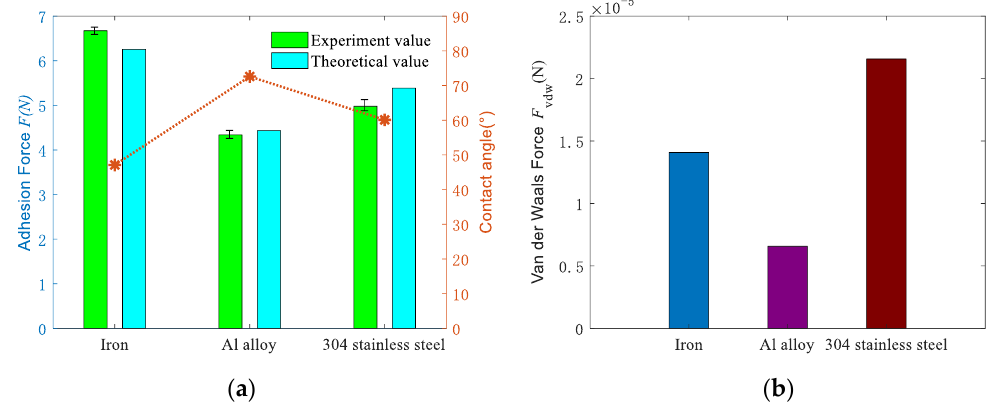
Figure 6. Influence of different materials on adhesion and van der Waals force: ( a ) comparison of experimental and theoretical values of adhesion force under different materials; ( b ) variation of van der Waals’ theoretical value under different materials.